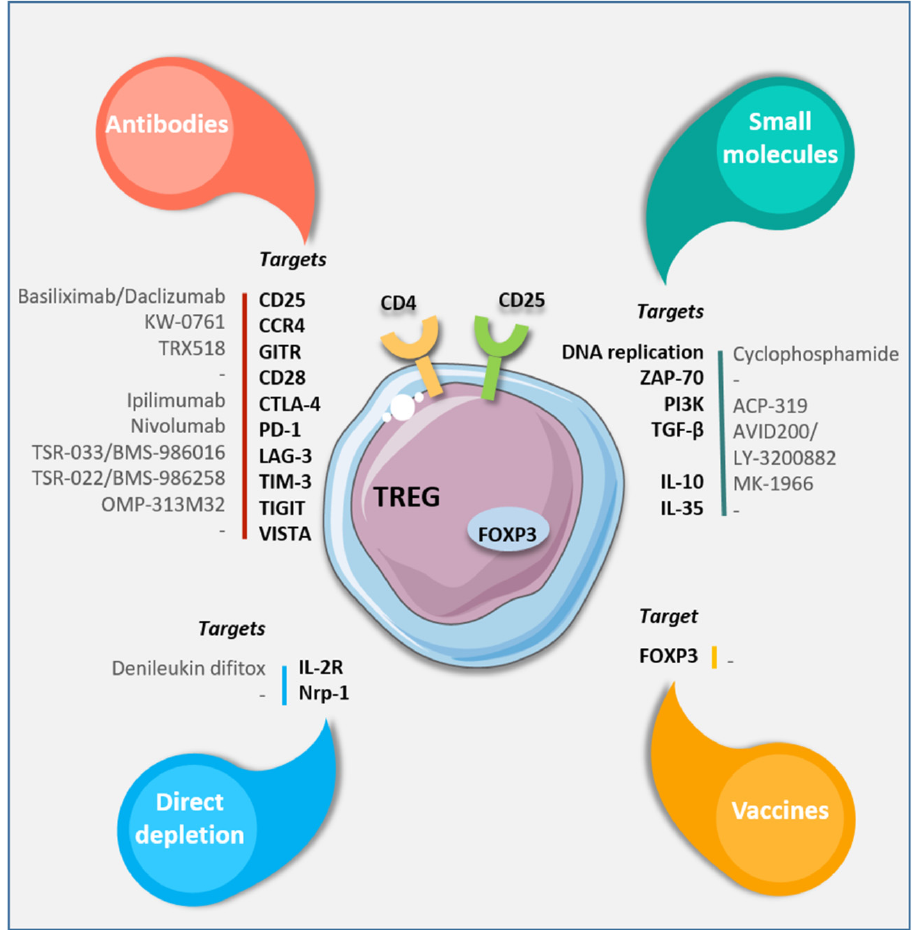
Figure 5. Targeting strategies to eliminate or modulate Treg functions. Available antibodies, small molecules, or vaccines specific for different cell surface or intracellular targets. From Laplagne et al. [61]. The transcription factor forkhead box P3 (Foxp3) is one of the most specific